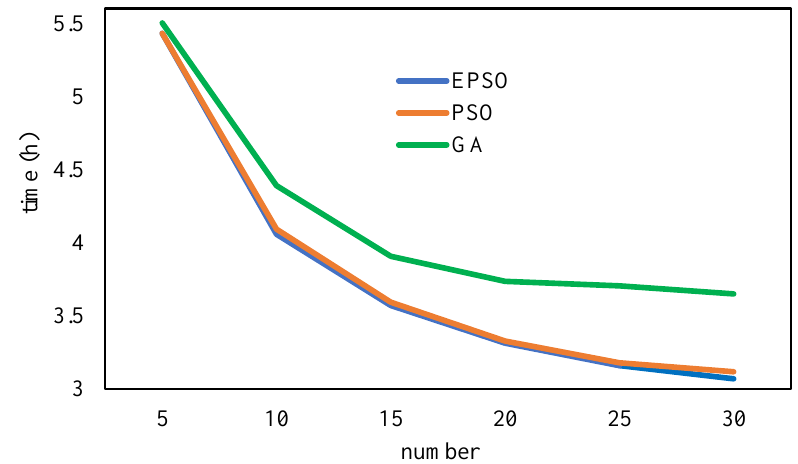
Figure 4. Average rescue time cost for different models only considering ship base station.